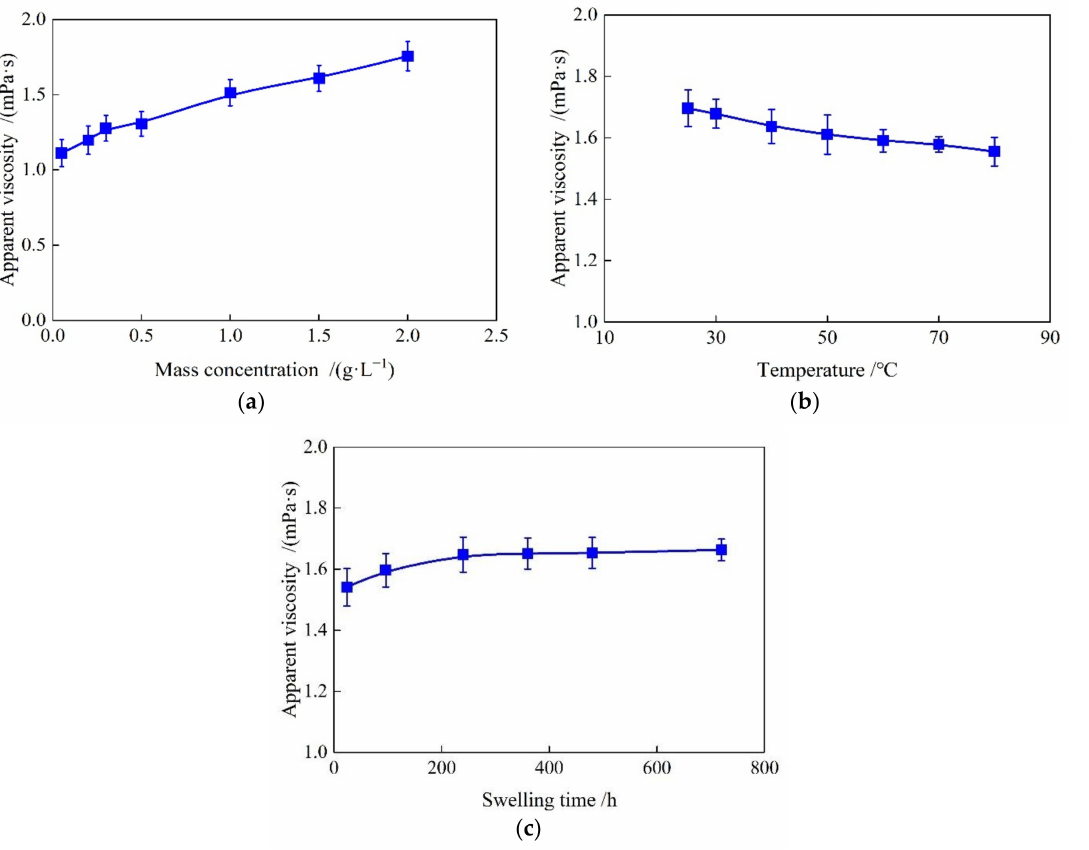
Figure 9. Apparent viscosity of SiO 2 /P(MBAAm- co -AM) polymeric nanoparticle solutions versus mass concentration ( a ) at a temperature of 60 ◦ C and a swelling time of 120 h, versus temperature ( b ) at a mass concentration of 1500 mg/L and a swelling time of 120 h, and versus swelling time ( c ) at a temperature of 60 ◦ C and a mass concentration of 1500